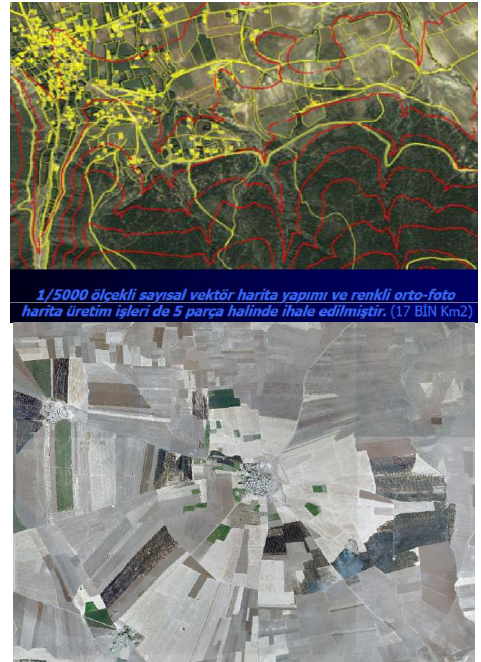
Figure 5. ARIP project context, photogrammetric map and